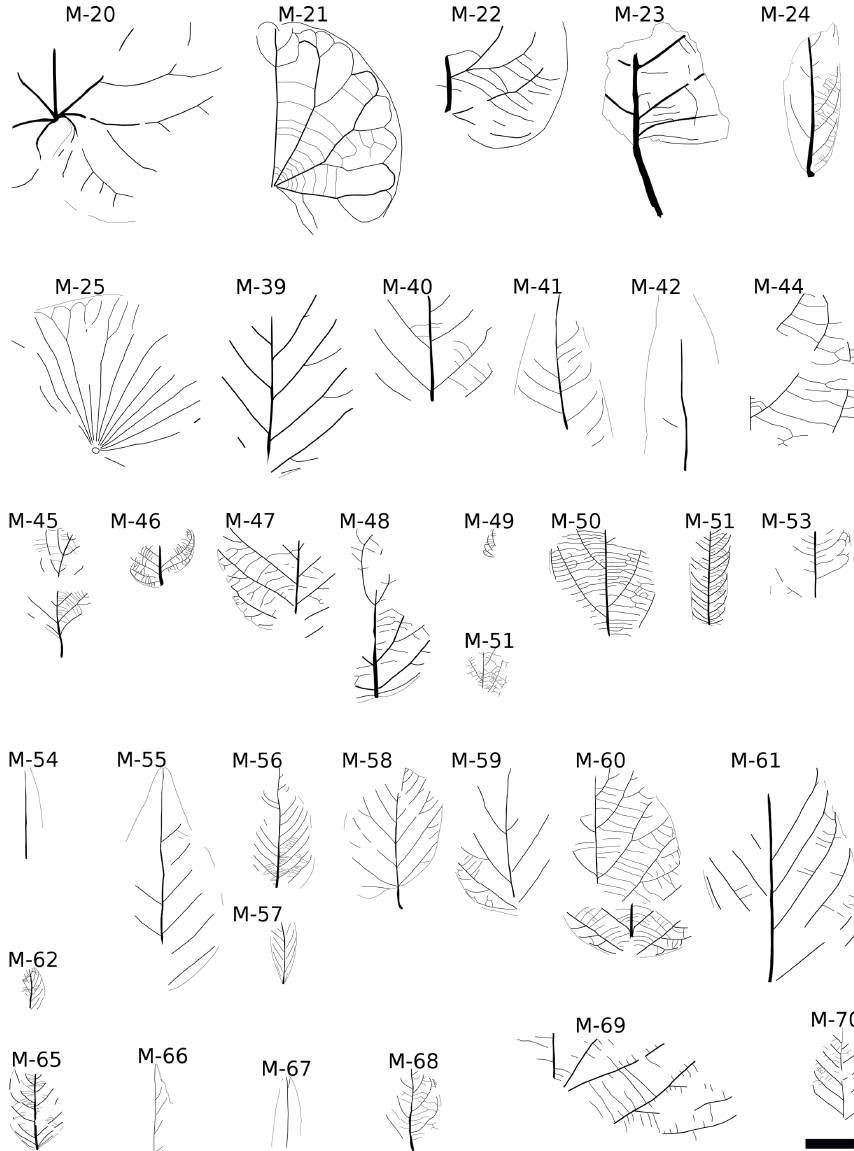
Figure 3. Line drawings of dicot leaf morphotypes, Baris, Egypt. The scale bar is 4cm.